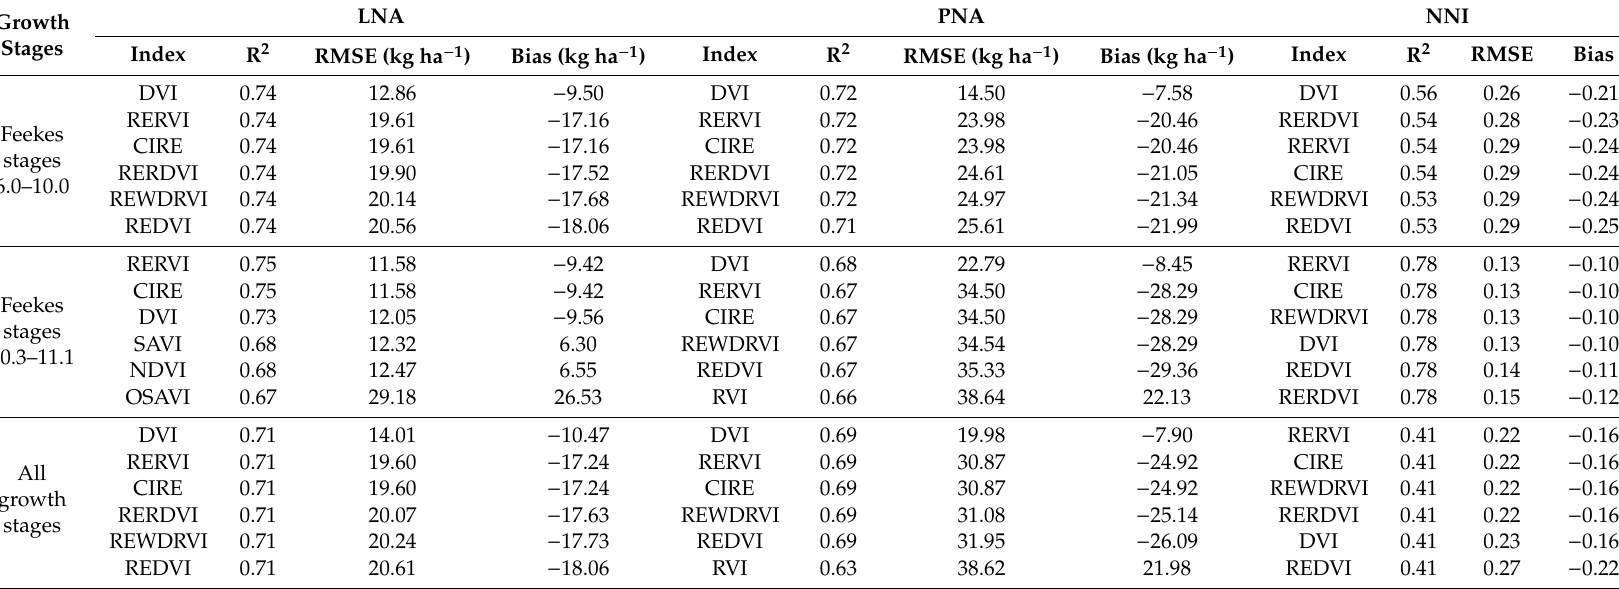
Table 7. Validation results for the pair-wise associations between top 6 vegetation indices and leaf nitrogen accumulation (LNA), plant N accumulation (PNA)